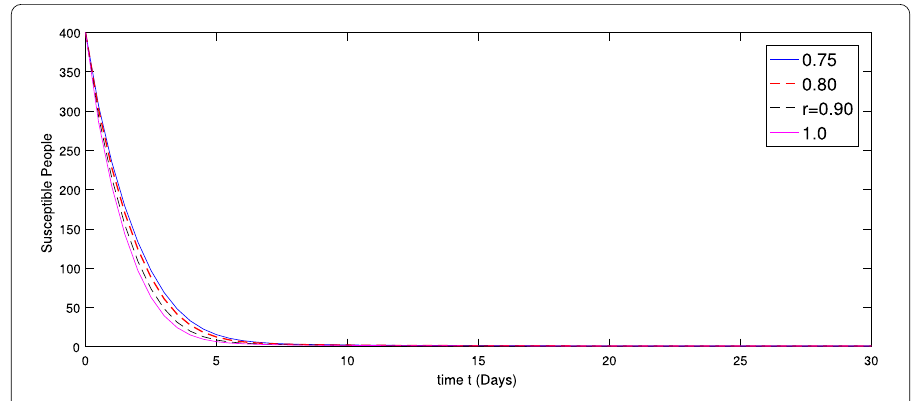
Figure 3 Graphical representation of approximate solutions up to five terms of susceptible population S ( t ) at different fractional order of the considered model (2)